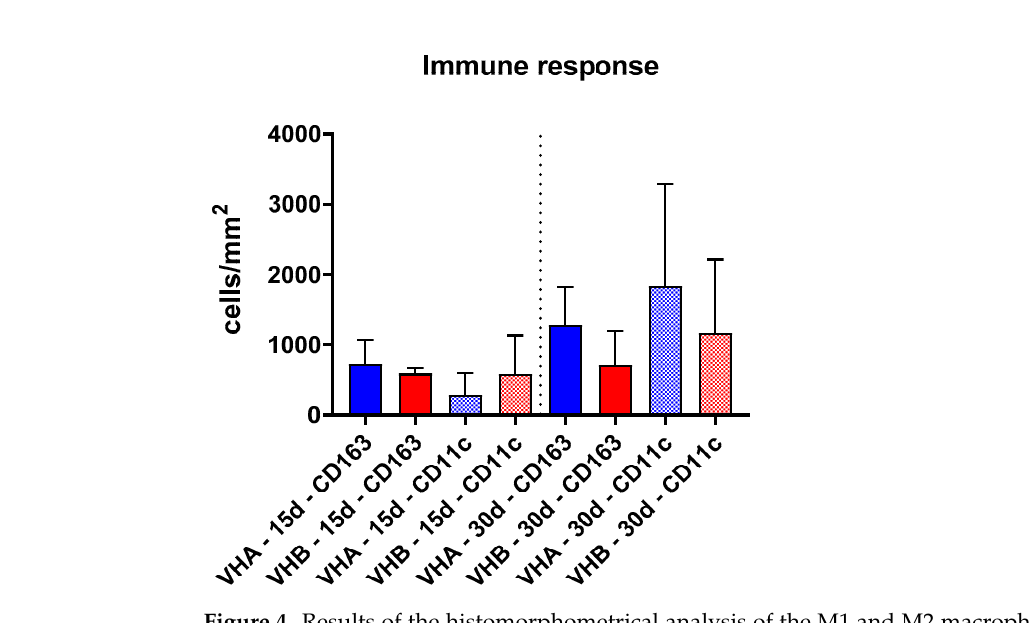
Figure 4. Results of the histomorphometrical analysis of the M1 and M2 macrophages within the implantation sites of both hydrogels (colored bars = anti-inflammatory cells, riffled bars = pro-in- flammatory cells).